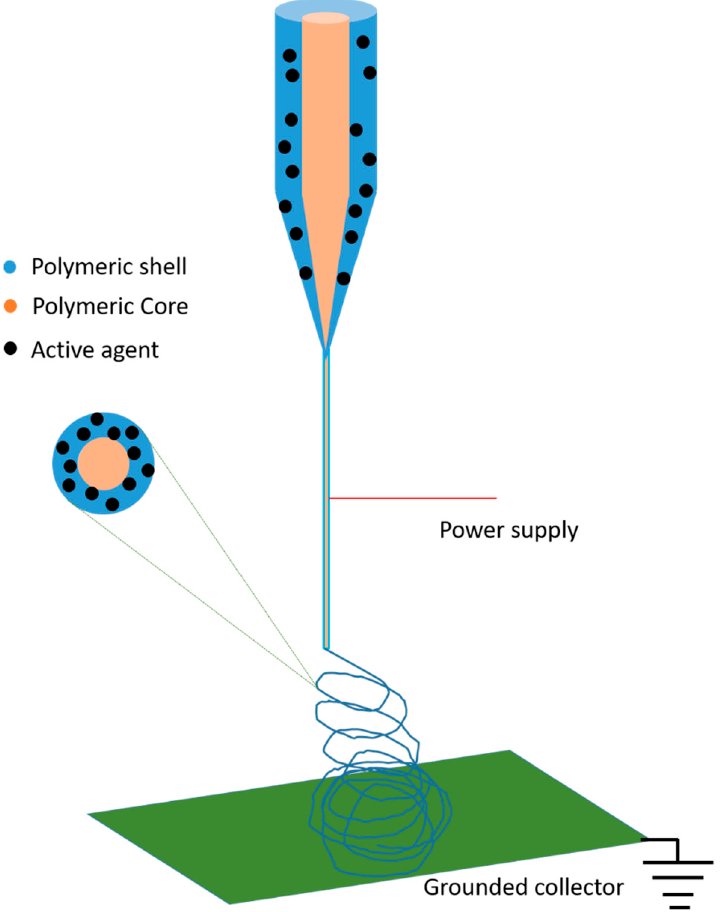
Figure 3. Schematic illustration of the electrospinning setup with two coaxial nozzle for spinning core-shell nanofibers.